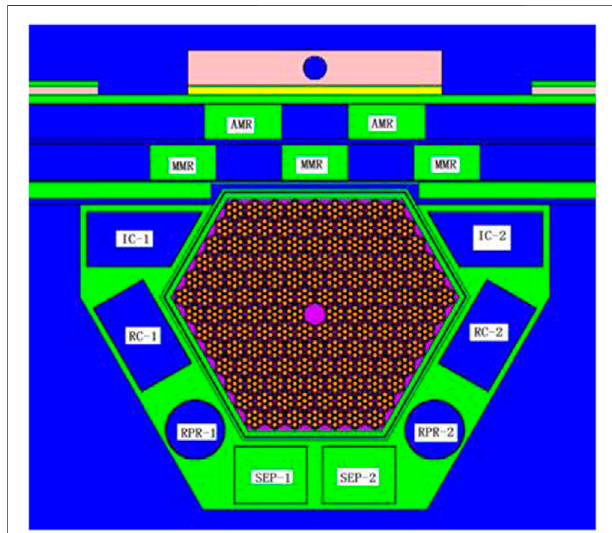
FIGURE 2 | Design scheme of